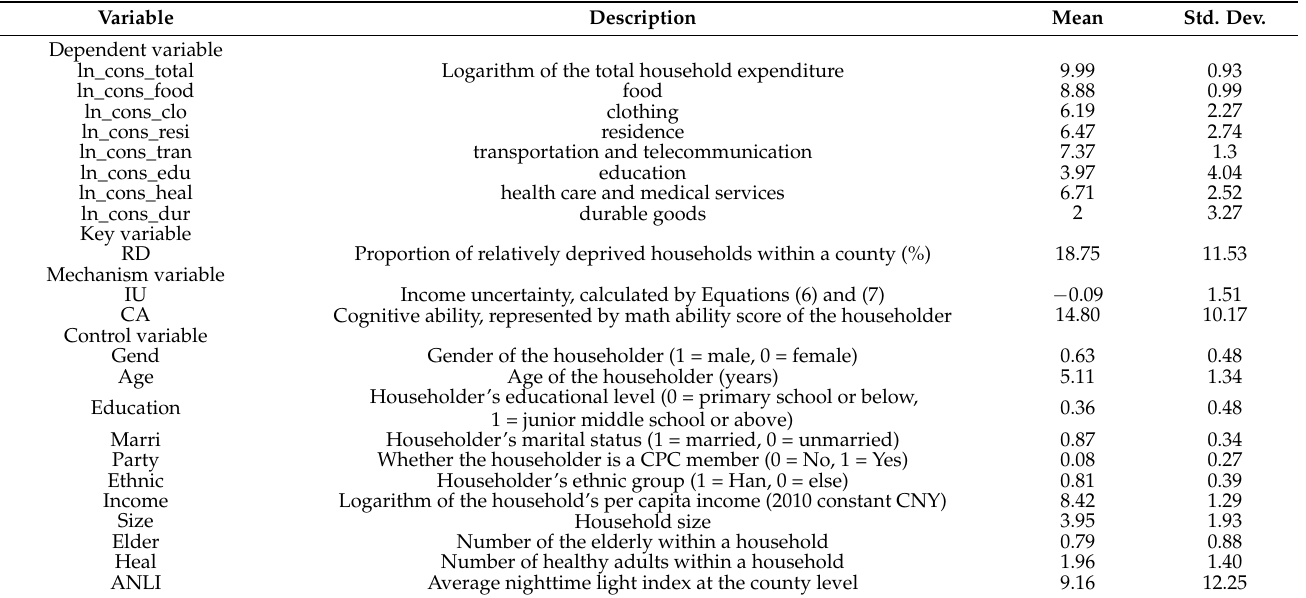
Table 1. Descriptive statistics of